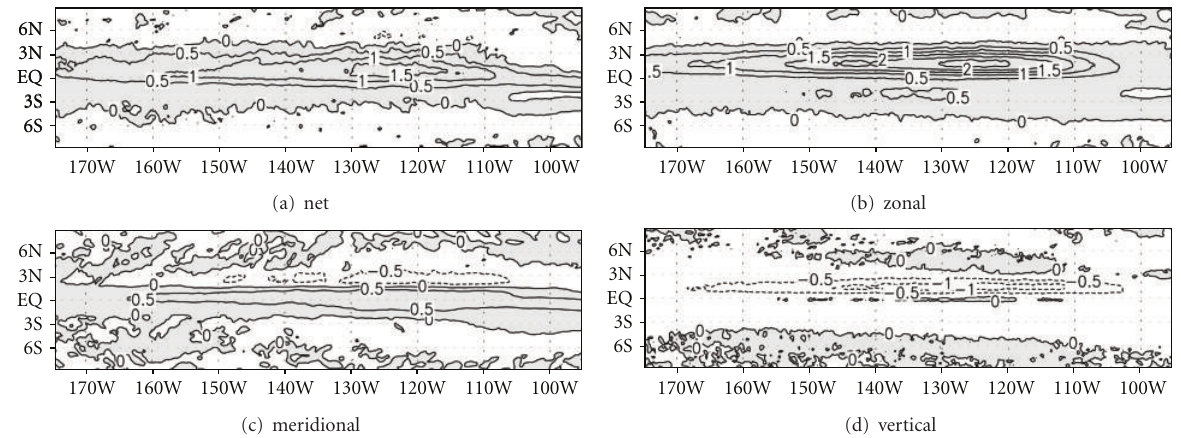
Figure 8: Distributions of temperature advection by TIWs obtained from (a) net advection, (b) zonal advection, (c) meridional advection, and (d) vertical advection. Each advection is averaged from August to December over the upper 50 m. Units are ◦ C/month. Positive values are shaded.